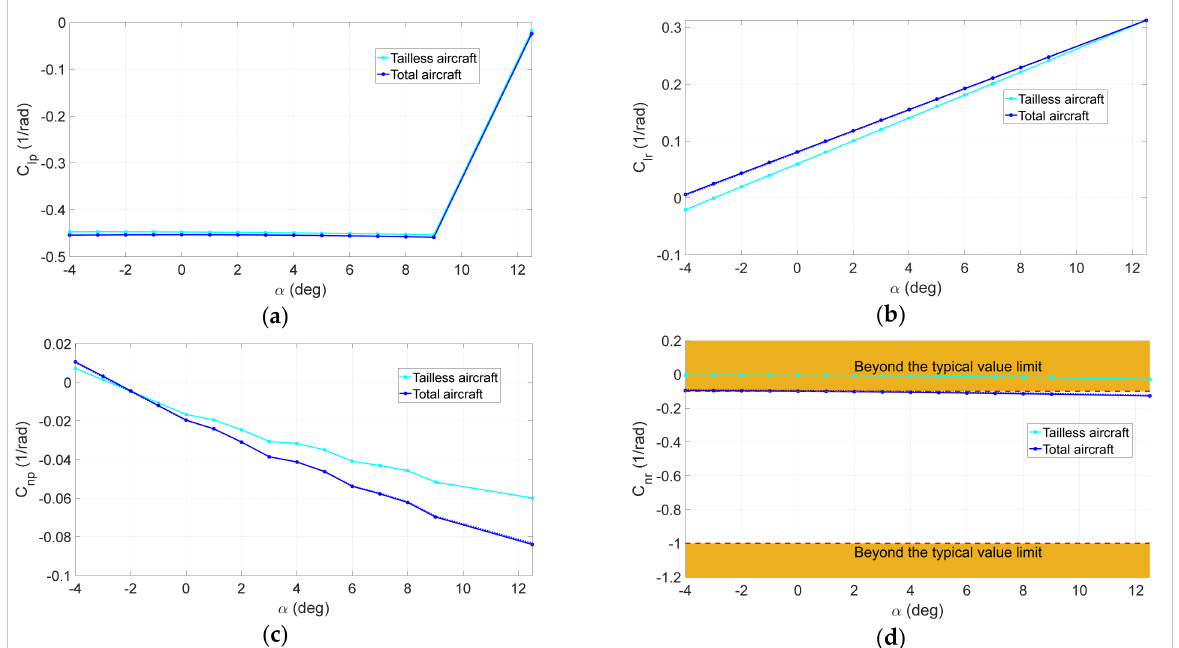
Figure 11. Lateral-directional dynamic characteristics of the proposed twin-engine aircraft model: ( a ) Damping in roll derivative results for the cruise condition; ( b ) roll due to yawing derivative results for the cruise condition; ( c ) yaw due to rolling derivative results for the cruise condition; ( d ) damping in yaw derivative results for the cruise condition; (solid lines account for the optimization using mass minimization scenario and dotted-lines are for drag optimization in trim